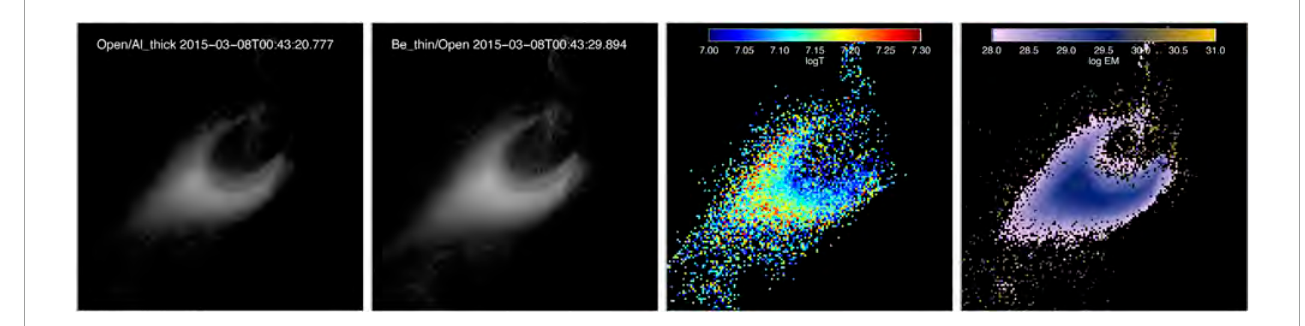
FIGURE 2 Left two images: XRT Al-Thick and Be-Thin, respectively, at about 00:43 UT on March 8. Right two images: Temperature and emission measure, respectively, calculated from the Al-Thick/Be-Thin filter ratio.